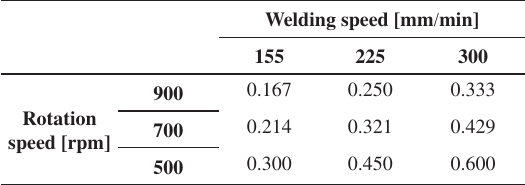
Figure 3. In this case, due to the discontinuous